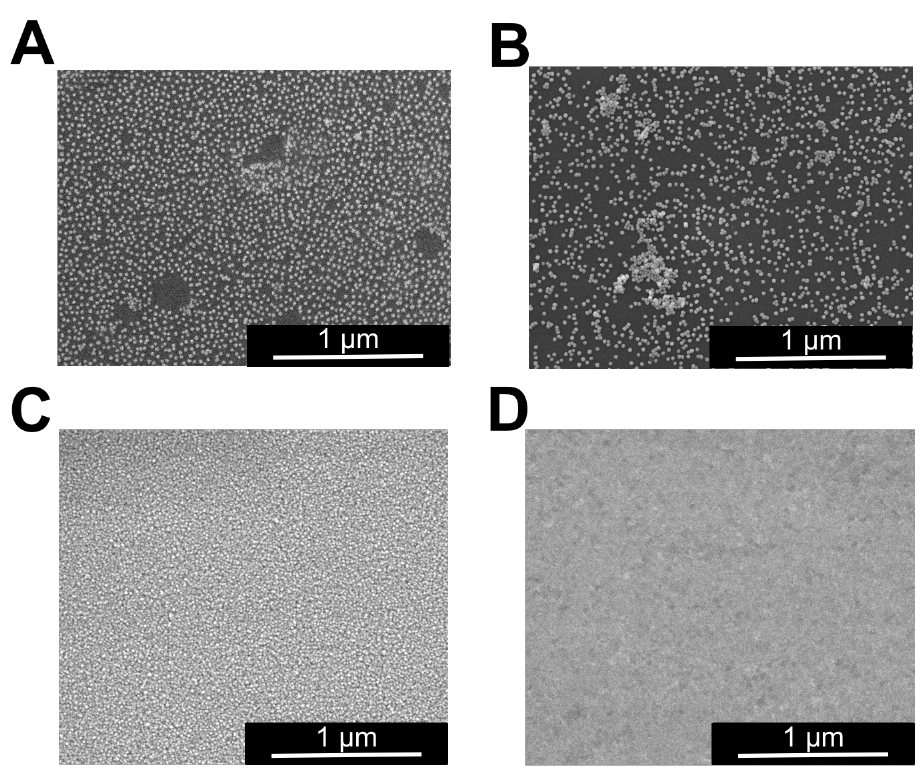
Figure A5. SEM images of the fiber surface covered with ( A ) gold and ( B ) silver nanoparticles, and ( C ) gold and ( D ) silver metallic thin